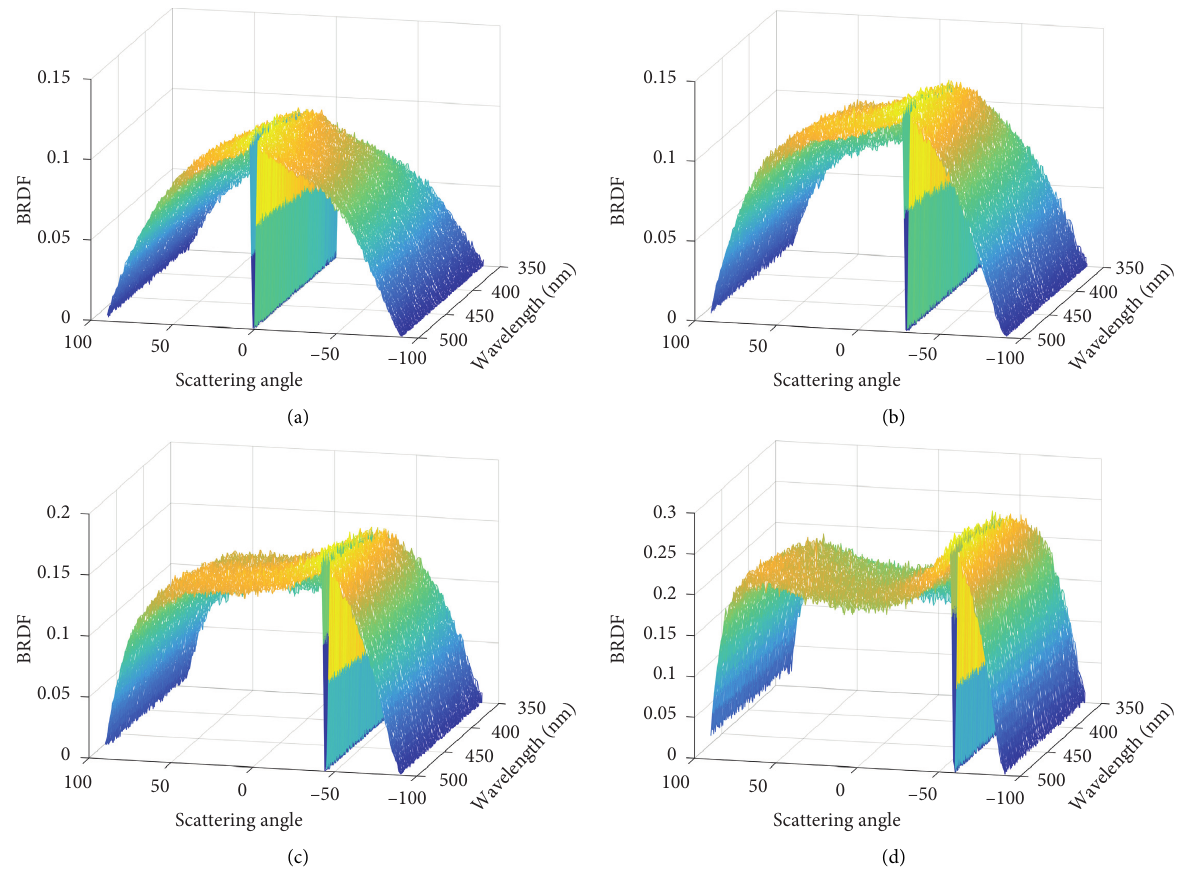
Figure 7: 3D graph of sample 4. (a) 3D data of 0 ° incident angle; (b) 3D data of 30 ° incident angle; (c) 3D data of 45 ° incident angle; (d) 3D data of 60 ° incident